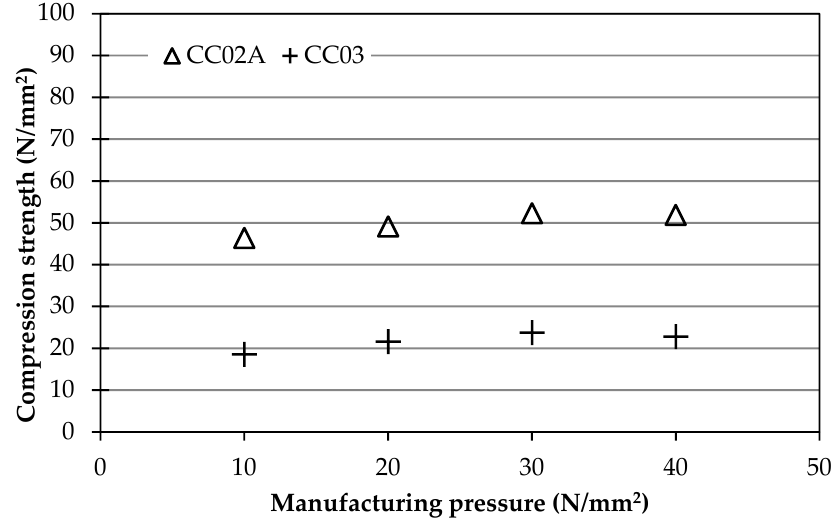
Figure 18. Compression strength (average of four tests) of recipes based on combustion chamber dust and oxy-cutting fines.